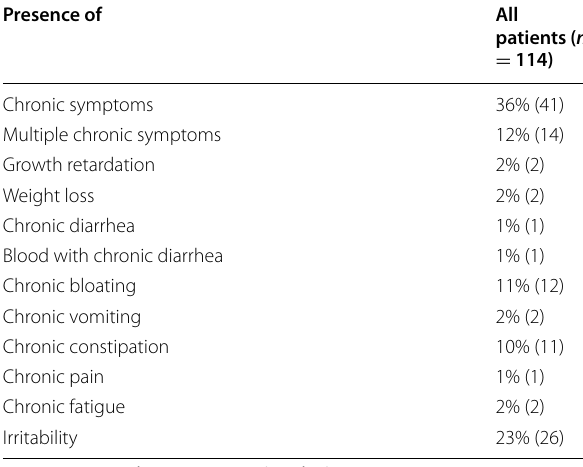
Table 4 Post hoc analysis of the incidence of recurrent symptoms in the groups of the study